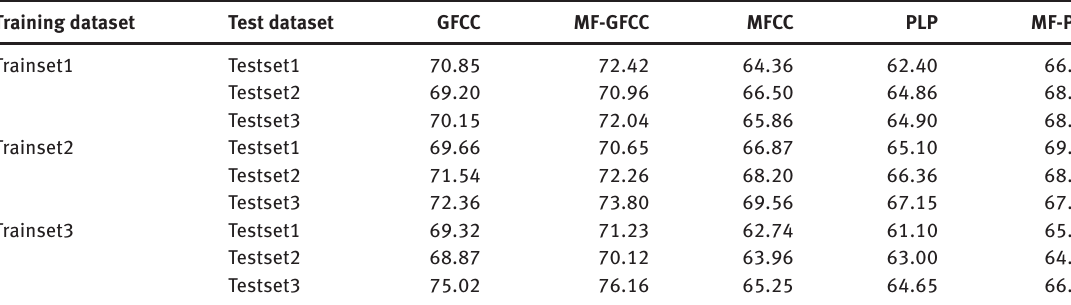
Table 1: Comparative Analysis of Feature Extraction Methods. Training